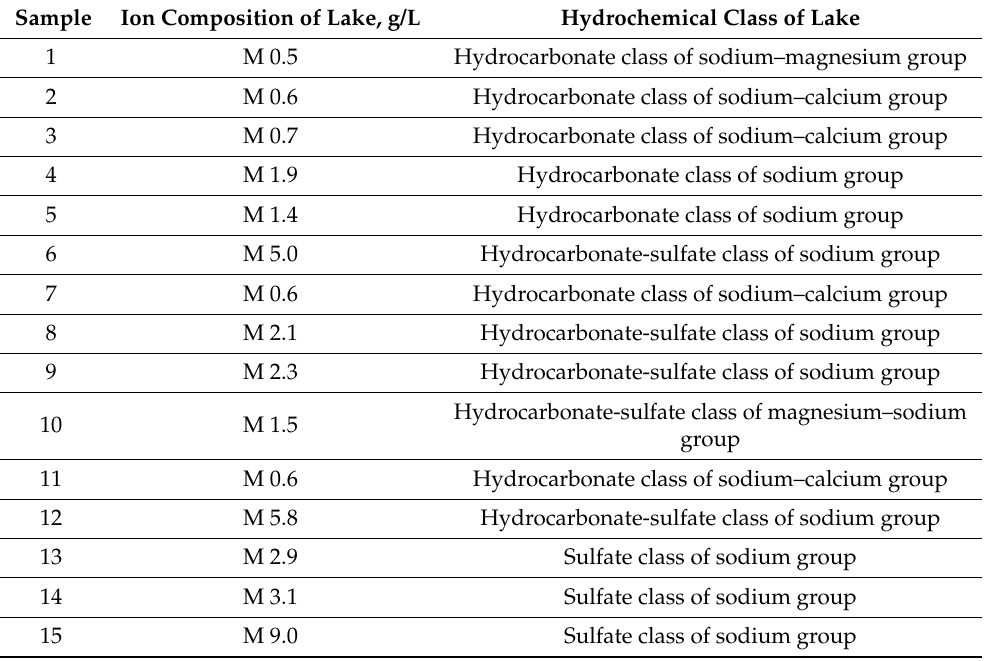
Table 5. Hydrochemical classes of lakes of Burabay